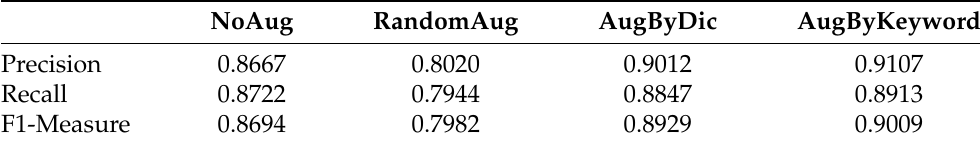
Table 3. The evaluation of the payload data augmentation